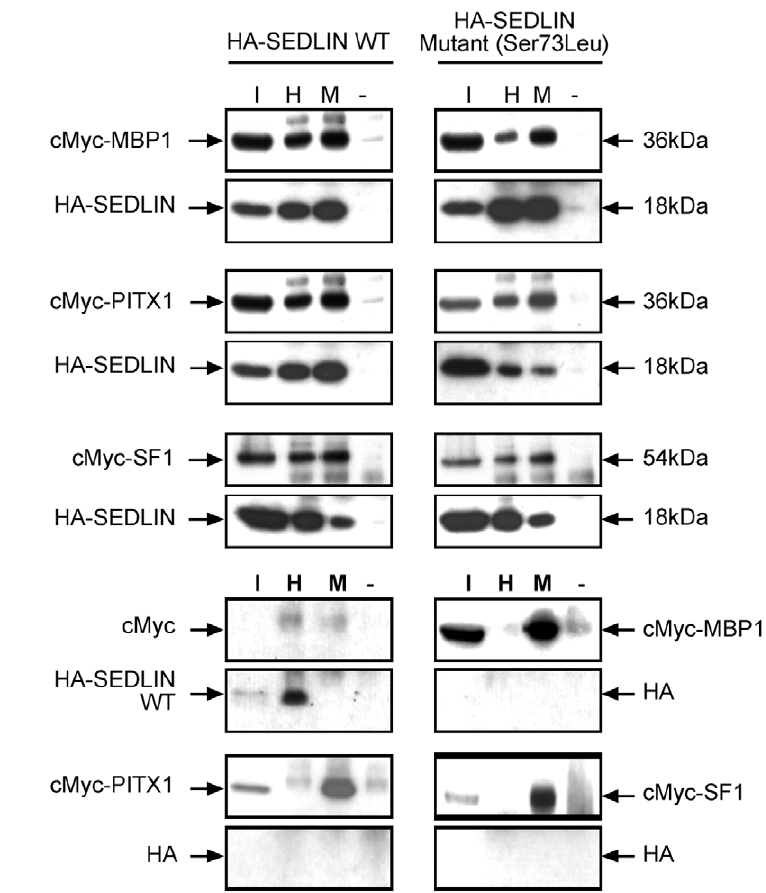
Figure 4. Interactions between SEDLIN, and MBP1, PITX1 and SF1. Co-immunoprecipitation studies using COS7 cells demonstrated interactions between wild-type SEDLIN, mutant SEDLINs (Asp47Tyr, Ser73Leu, Phe83Ser, Val130Asp and Gln131Stop, only data from Ser73Leu SEDLIN shown) and MBP1, PITX1 and SF1. (A) cMyc-MBP1 co-transfected with wild-type or mutant HA-SEDLIN; (B) cMyc-PITX1 co-transfected with wild-type or mutant HA- SEDLIN; (C) cMyc-SF1 co-transfected with wild-type or mutant HA-SEDLIN; and (D) empty cMyc vector co-transfected with HA-SEDLIN or empty HA vector co-transfected with cMyc-MBP1, cMyc-PITX1 or cMyc-SF1 constructs. Lysates were incubated with either anti-cMyc polyclonal antibody (M) or anti-HA polyclonal antibody (H), or without any antibody as a negative control ( 2 ) and immunoprecipitated with Protein G-Sepharose beads. Protein complexes immunoprecipitated lysates. Wild-type SEDLIN co-immunoprecipitated MBP1, PITX1 and SF1 and the SEDLIN mutations (Asp47Tyr, Ser73Leu, Phe83Ser, Val130Asp and Gln131Stop) did not disrupt these interactions (representative data for mutant Ser73Leu SEDLIN